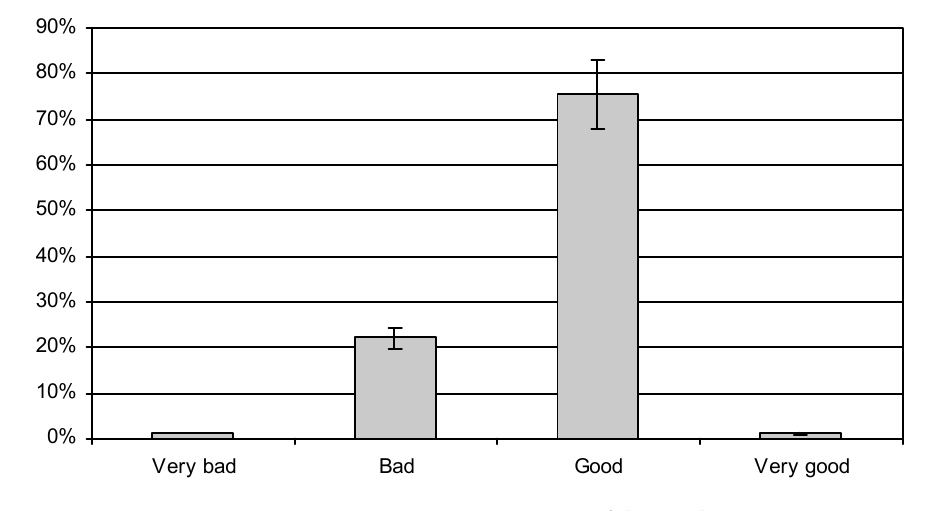
Figure 8. The consumption of fast food and sweets by participants.